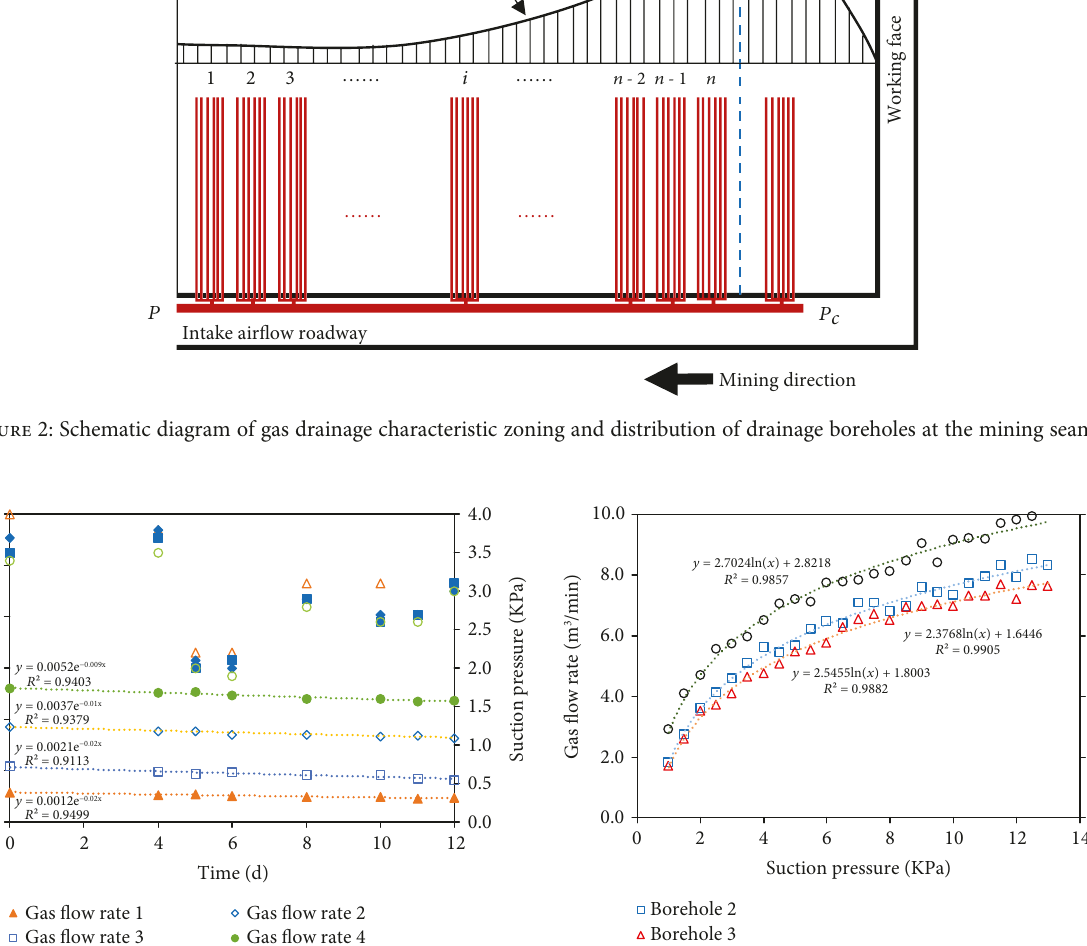
y = 0.0037e − 0.01x R ² = 0.9379 y = 0.0021e − 0.02x R ² = 0.9113 y = 0.0012e − 0.02x R ² = 0.9499